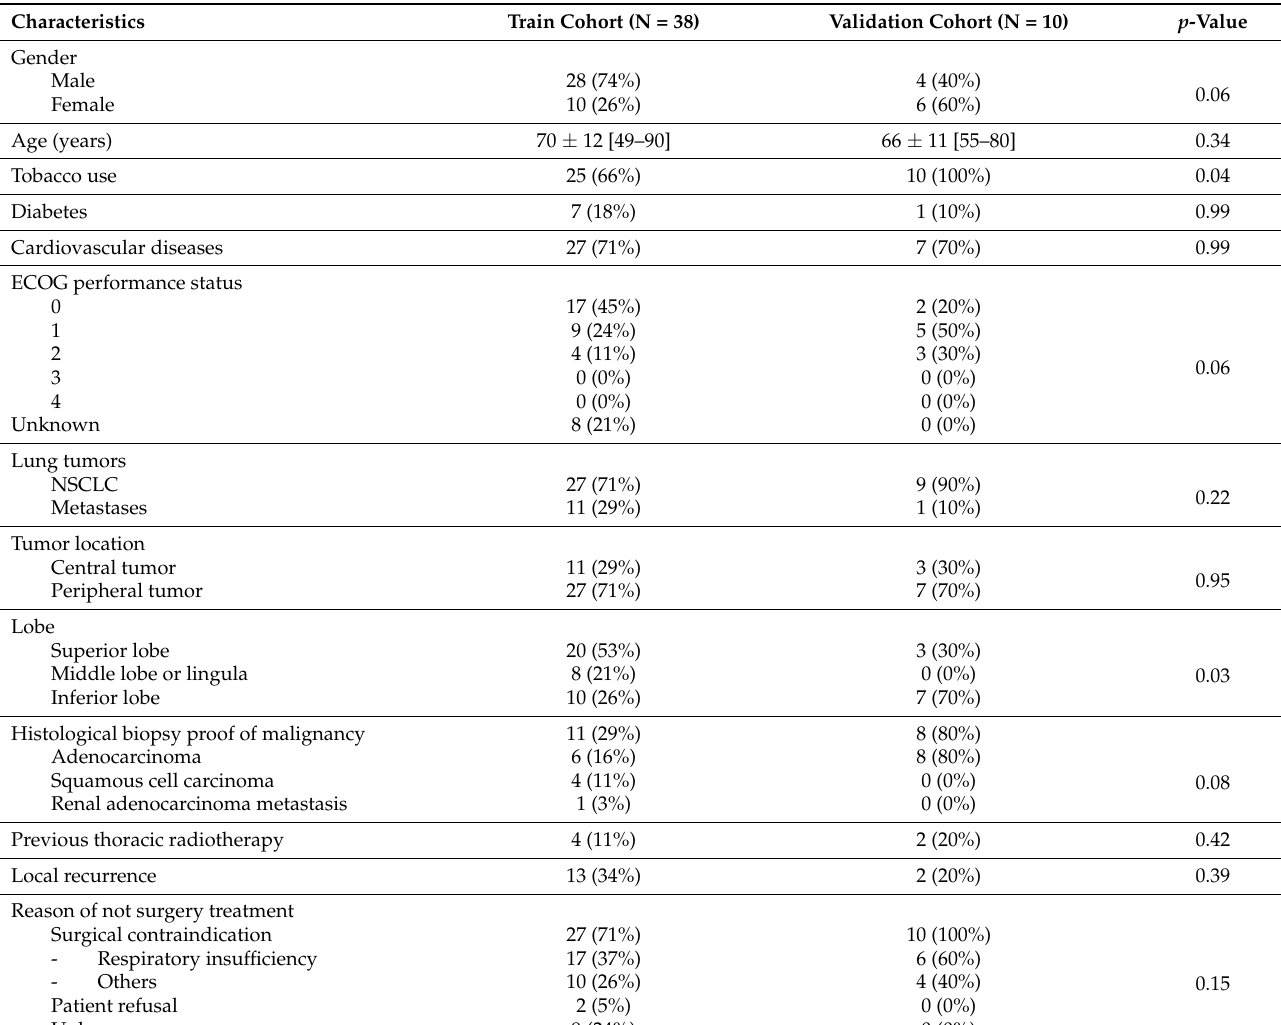
Figure 1. Flow chart of the study. Table 1. Patient characteristics.